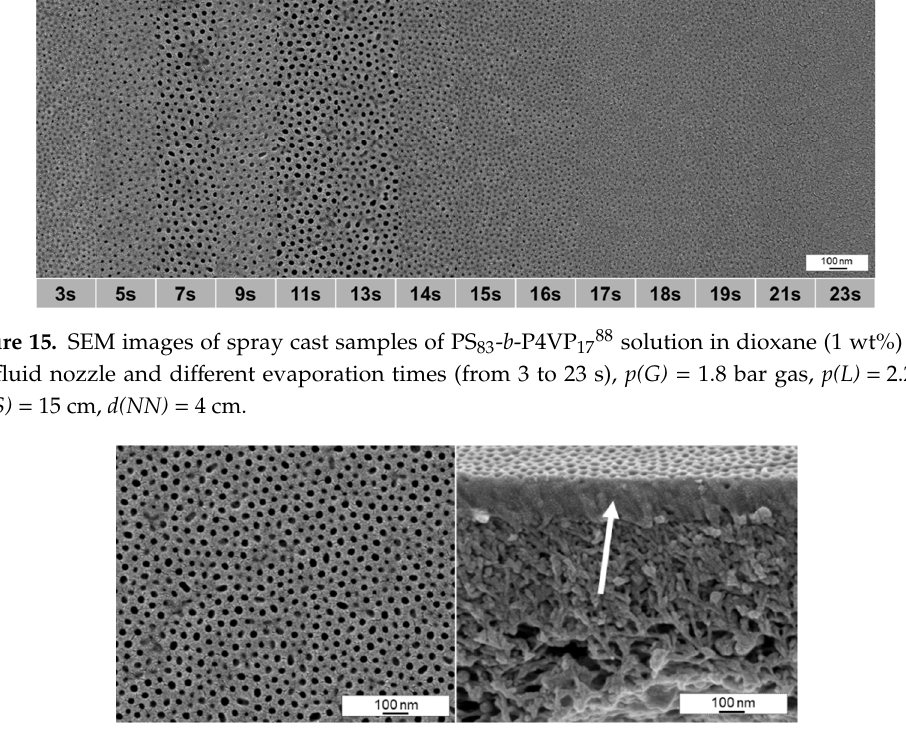
Figure 16. SEM image of the surface ( left ) and cross-section ( right ) of a spray cast sample of PS 83 - b - P4VP 1788 solution in 1,4-dioxane (1wt%) with a 2-fluid nozzle and an evaporation time of 11 s, p(G) = 1.8 bar gas, p(L) = 2.2 bar, d(NS) = 15 cm, d(NN) = 4 cm. The arrow points to the dense BCP part of